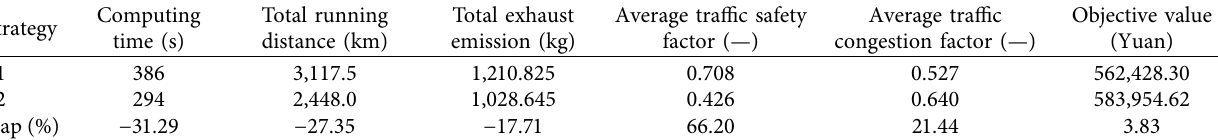
Table 7: Comparison of optimization results between two strategies.